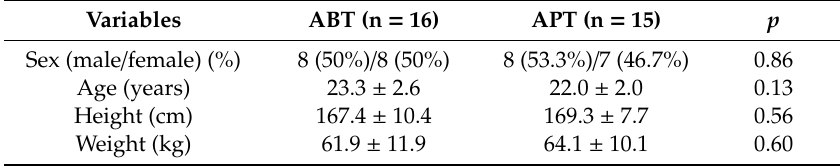
Table 1. General characteristics of the study participants in each group (n = 31).